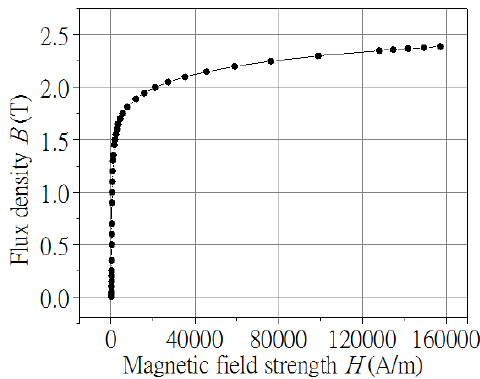
Figure 7. B-H curve of AISI 1020 carbon steel.